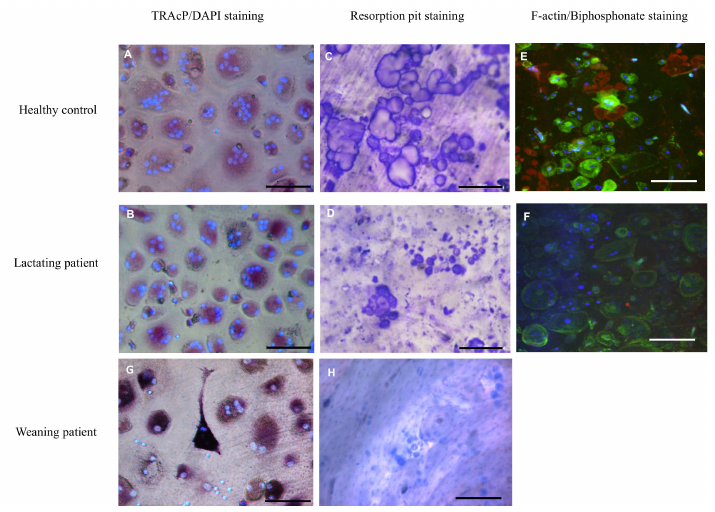
Figure 1. Osteoclast cultures. Osteoclasts were generated from CD14 + cells with MCSF and RANKL for 4 weeks and subsequently fixed and stained for TRAcP (red); nuclei were visualized with DAPI (blue). Cells from both the healthy control ( A ) and the lactating patient ( B ) generated multinucleated osteoclasts. Control osteoclasts cultured on trabecular bone slices generated resorption trenches ( C ). This was in contrast to the osteoclasts of the patient where only small round resorption pits were visible ( D ). Confocal microscopy showed that actin rings, visualized with phalloidin-alexa488 (green), were abundantly present in cells of the control ( E ). These actin rings were hardly visible in cells of the patient ( F ). Staining the resorption area with alexa-647-labeled bisphosphonate (red) revealed less resorption by cells of the patient compared to the control (Figure 1E compared to Figure 1F). The nuclei were stained with DAPI (blue). TRAcP staining and resorption of osteoclasts from the patient during weaning is displayed in G , H . Scalebar 100 µ